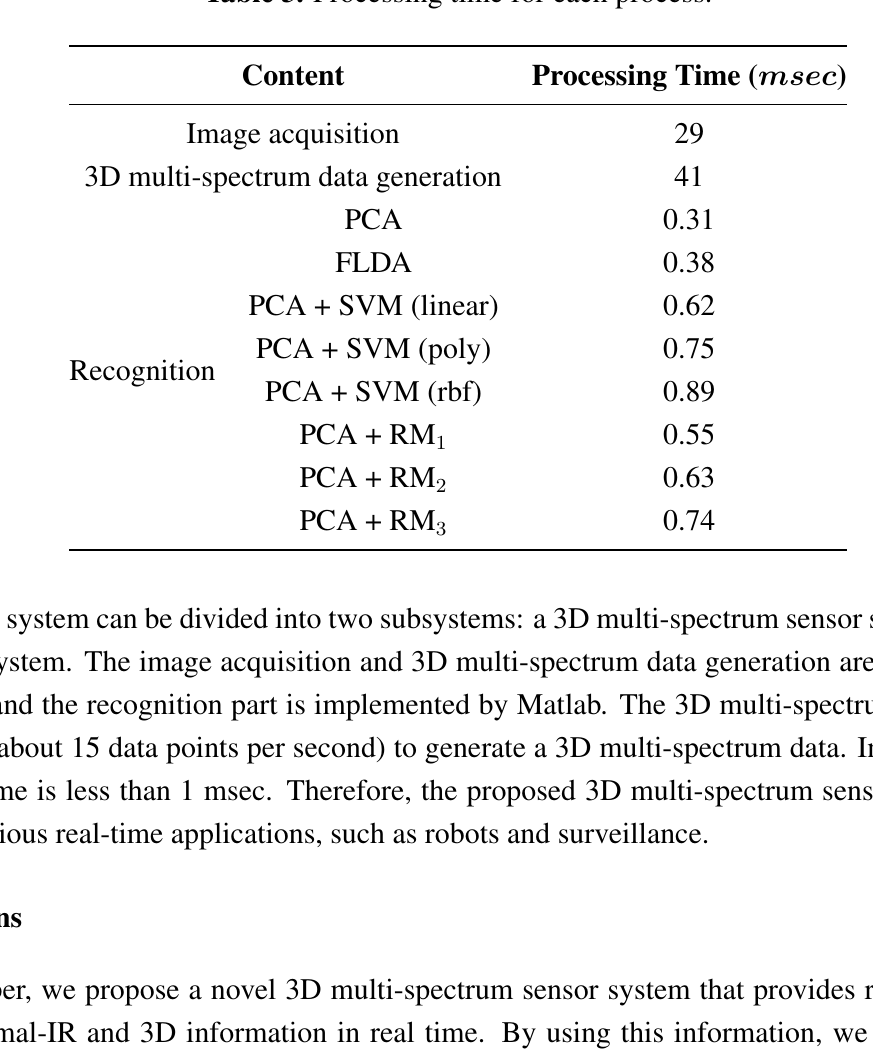
Table 3. Processing time for each